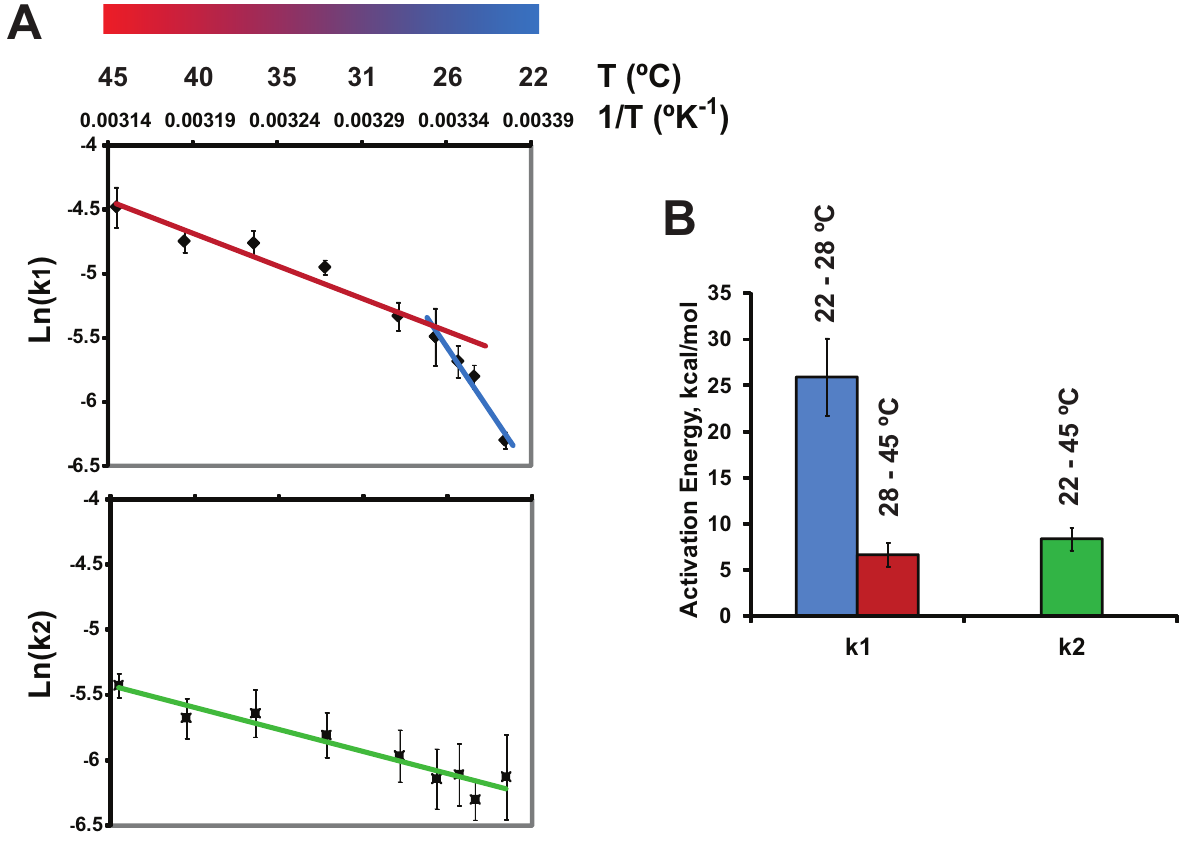
Figure 6. The first kinetic constant (k 1 ), but not the second (k 2 ), displays a transition (discontinuous slope) in the Arrhenius plot. A representative Arrhenius plot (A) and activation energies (E a ) associated with the kinetic constants k 1 and k 2 (B). E a values were determined from the slopes of replicate Arrhenius plots (similar to one shown in panel A). The two E a values associated with k 1 correspond to the temperatures above and below the transition point. The transition temperature is represented by the break-point on the Arrhenius plot (A) and was found to be 27.9 6 0.7 u C, mean 6 SE, n =5. Data in (A) are means 6 S.E of 4–9 replicates; data in (B) are means 6 S.E of seven separate OMV preparations.